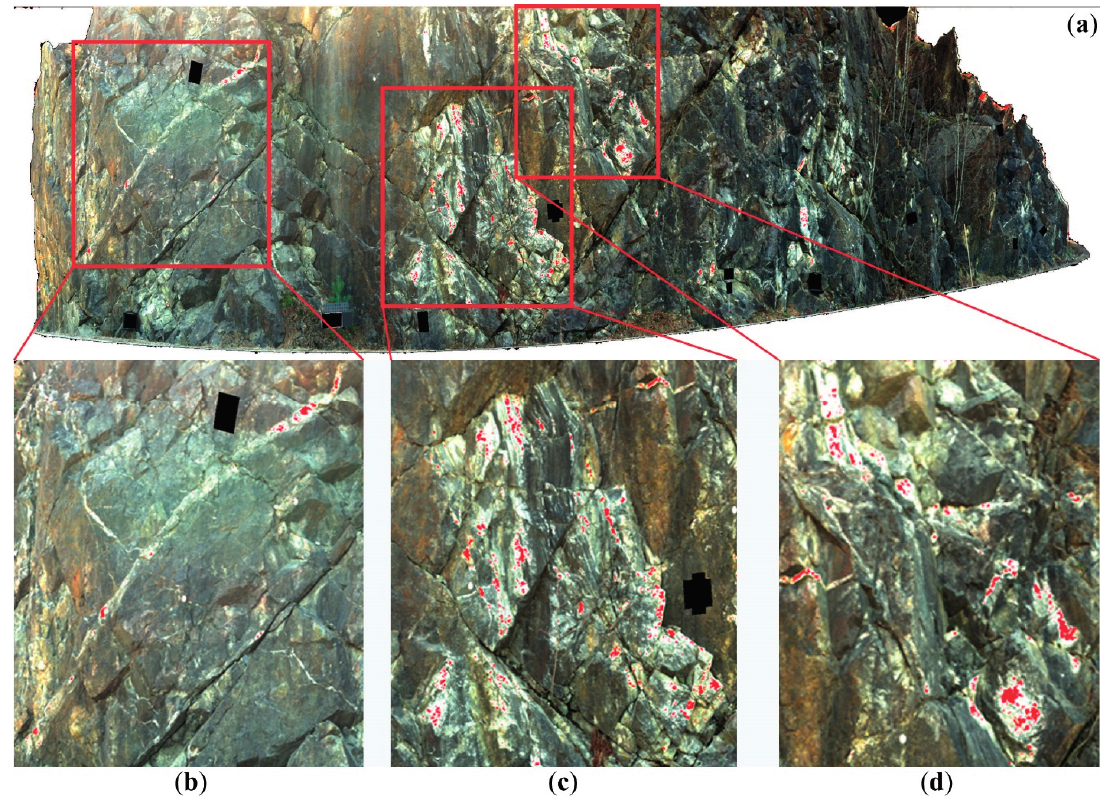
Figure 6. ( a ) REE thematic map of the søvite outcrop based on R-L deconvolution and combined with absorption depth determination. Red pixels indicate the enriched portion of the outcrop; ( b – d ) are the zoom images of the most important zones. Reference panels and the ground control points (for georeferencing) are colored black. The image highlights the local neodymium distribution as an indicator for LREE. The center area (c,d) is